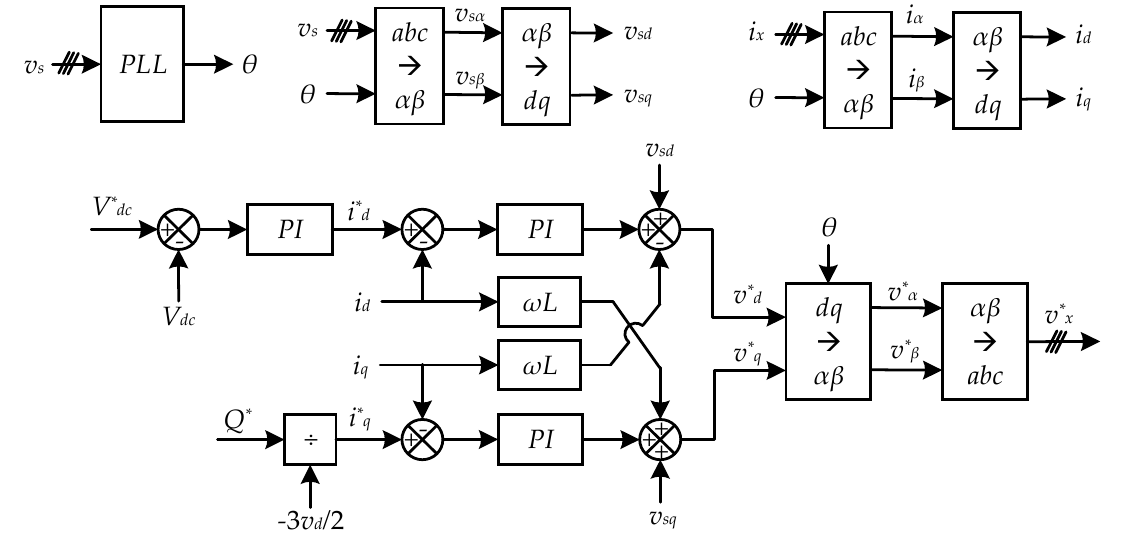
Figure 8. Output voltage and current control under balanced grid condition.